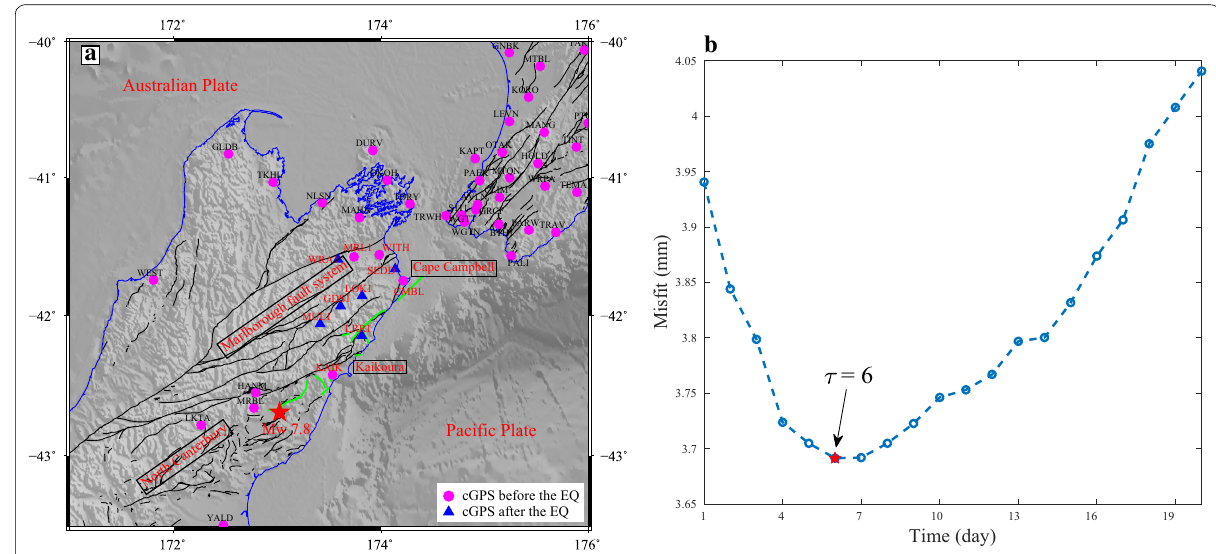
Fig. 2 Postseismic position time-series analysis. a Spatial distribution of stations used for the postseismic study. The magenta circles and blue triangles are GPS stations installed before and after the earthquake, respectively. b Optimal relaxation time based on the use of ten stations (marked with red labels in a ) in the near